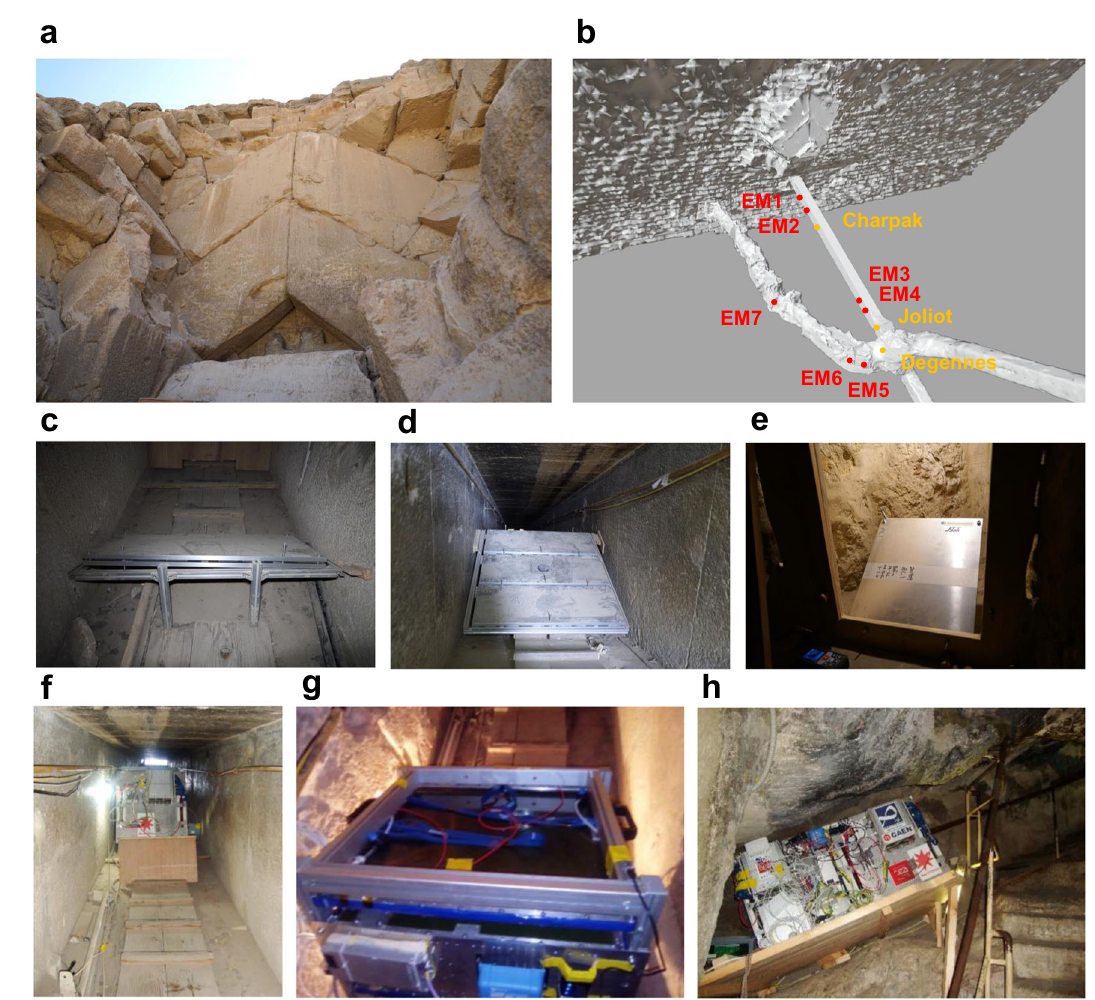
Fig.2|DetectorsinstalledintheDCandintheMC.a TheChevron,whichconsists of huge gabled limestone beams, covering the original entrance to the DC on the North side of Khufu ’ s Pyramid. b 3D model and positions of the detectors from